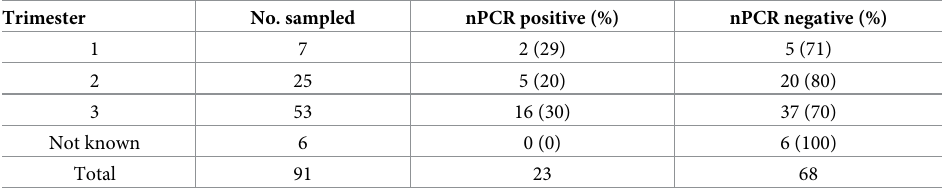
Table 3. Detection of Toxoplasma gondii genomic DNA in blood collected from seropositive pregnant women per trimester of